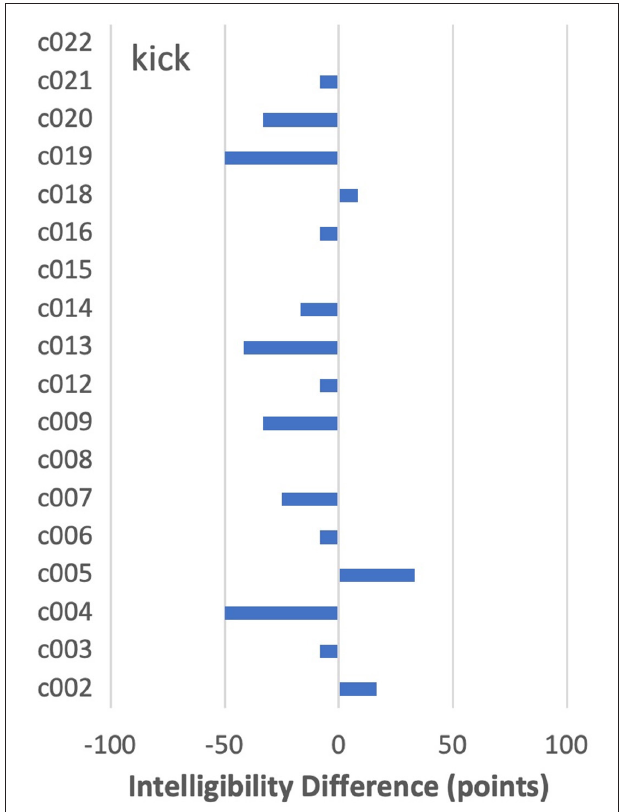
FIGURE 6 | By-speaker differences between mean intelligibility scores on the two tasks for kick